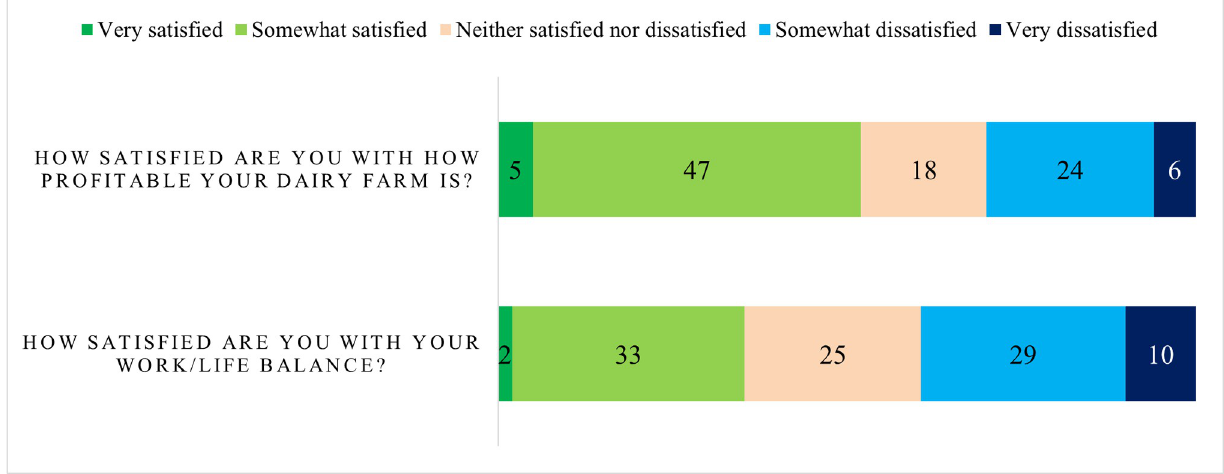
Fig 3. Satisfaction with profitability and work life balance.